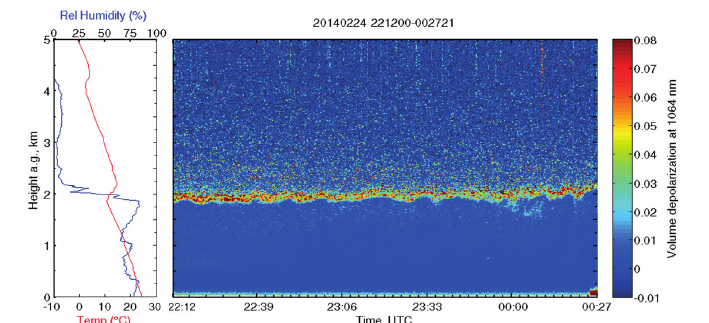
Figure 2: The temperature and relative humidity profile of the radiosonde launched at 24 February 2014 23:07 UTC (left) and the height-time display of the 1064 nm volume linear depolarization ratio (right).